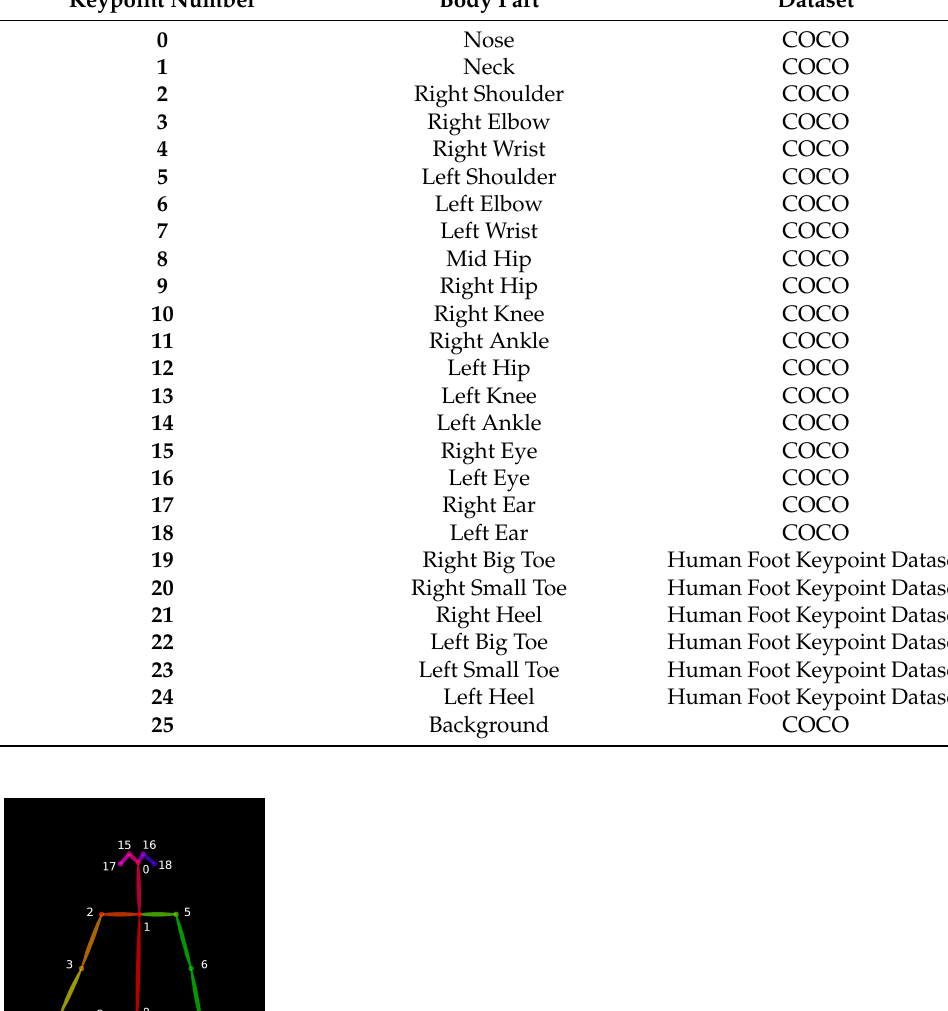
Table A1. OpenPose Body_25 body part mapping guide.